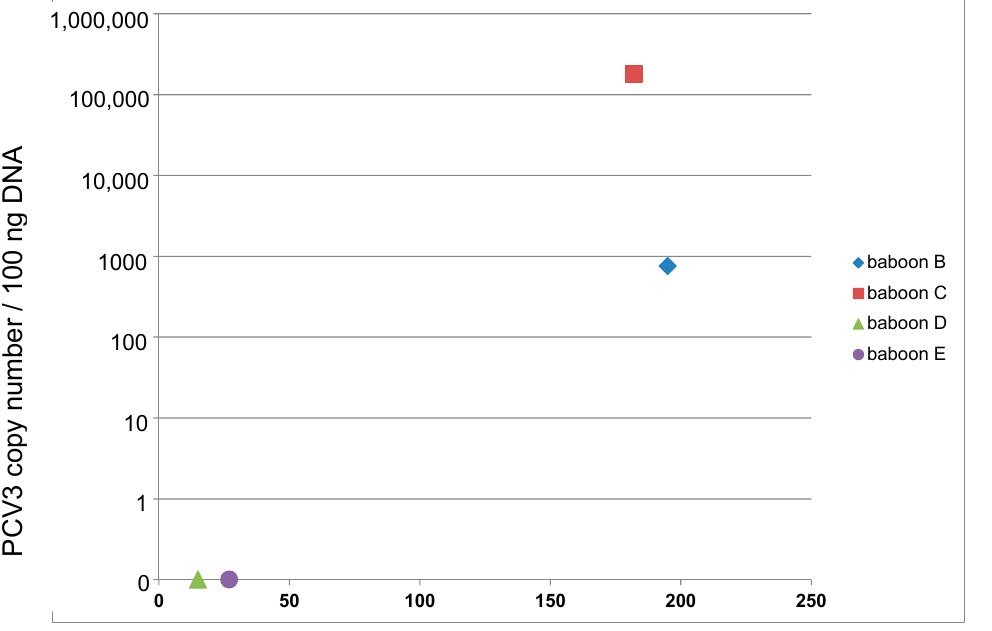
Figure 2. Correlation between the virus load of PCV3 and the survival time of the recipient. The PCV3 copy number is shown for 100 ng DNA in a logarithmic scale which has been modified to show the zero values of baboons D and E.